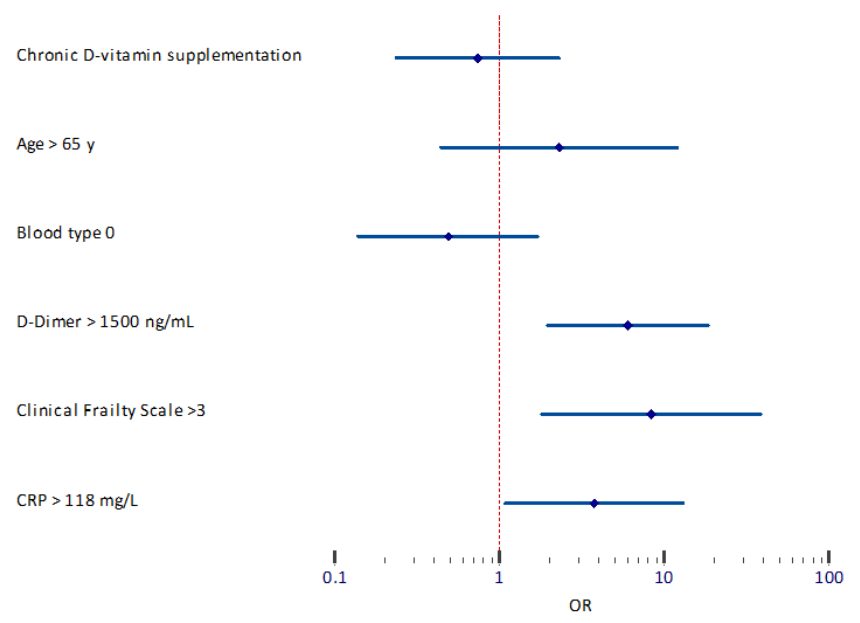
Figure 2. Predictors of 3-month mortality. Forest plot-multivariable logistic regression. Logarithmic scale.